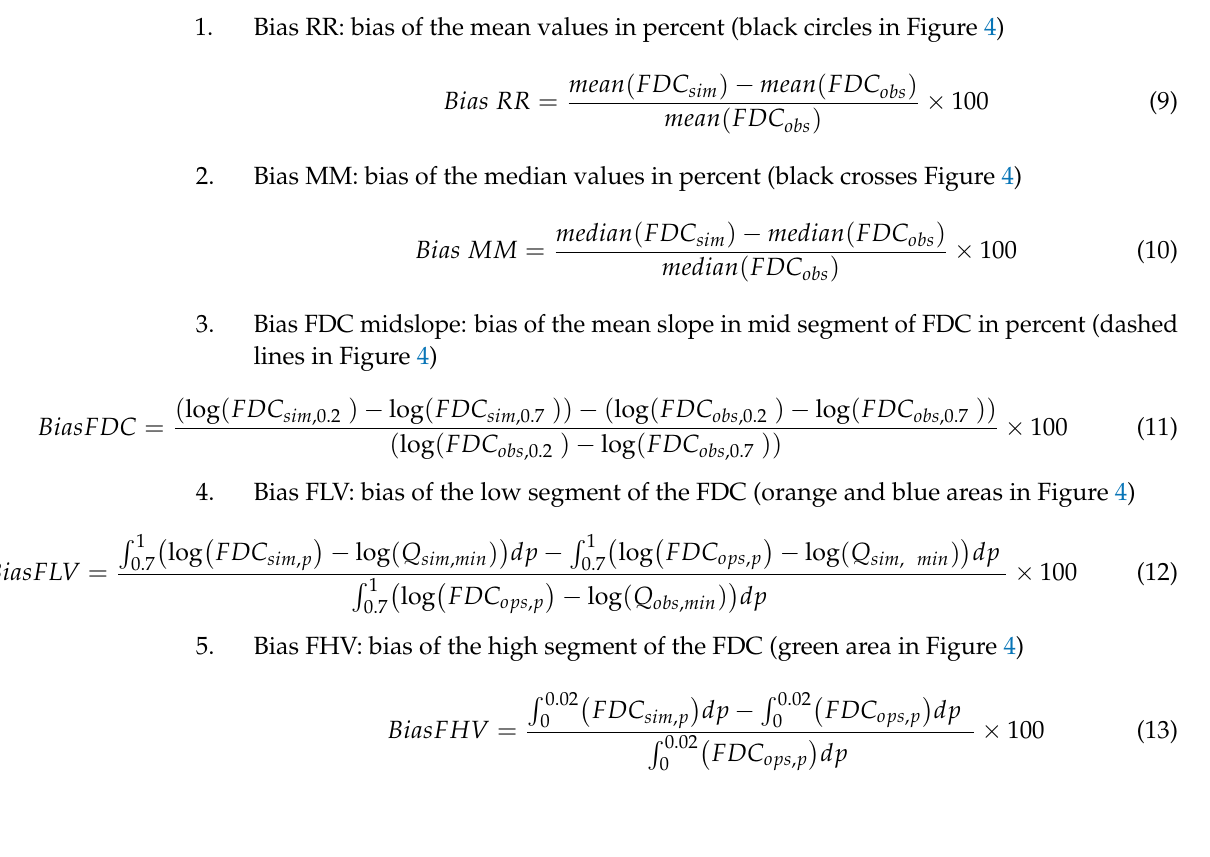
Bias MM: bias of the median values in percent (black crosses Figure 4)